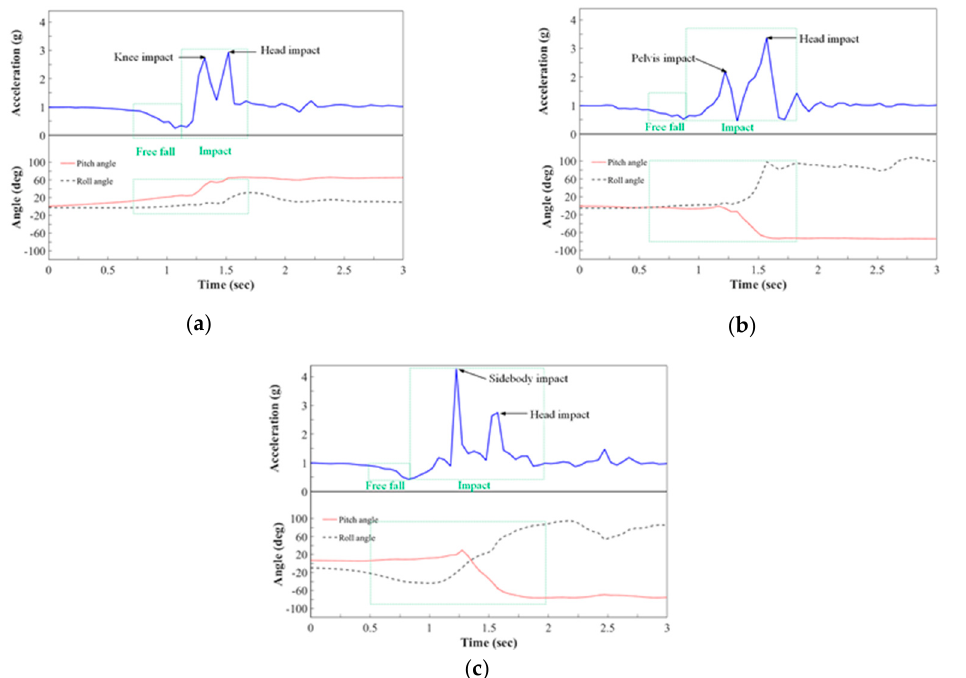
Figure 7. RMS acceleration along with pitch and roll angles during fall experiment. ( a ) Forward fall (trip); ( b ) Backward fall (slip); ( c ) Lateral fall.